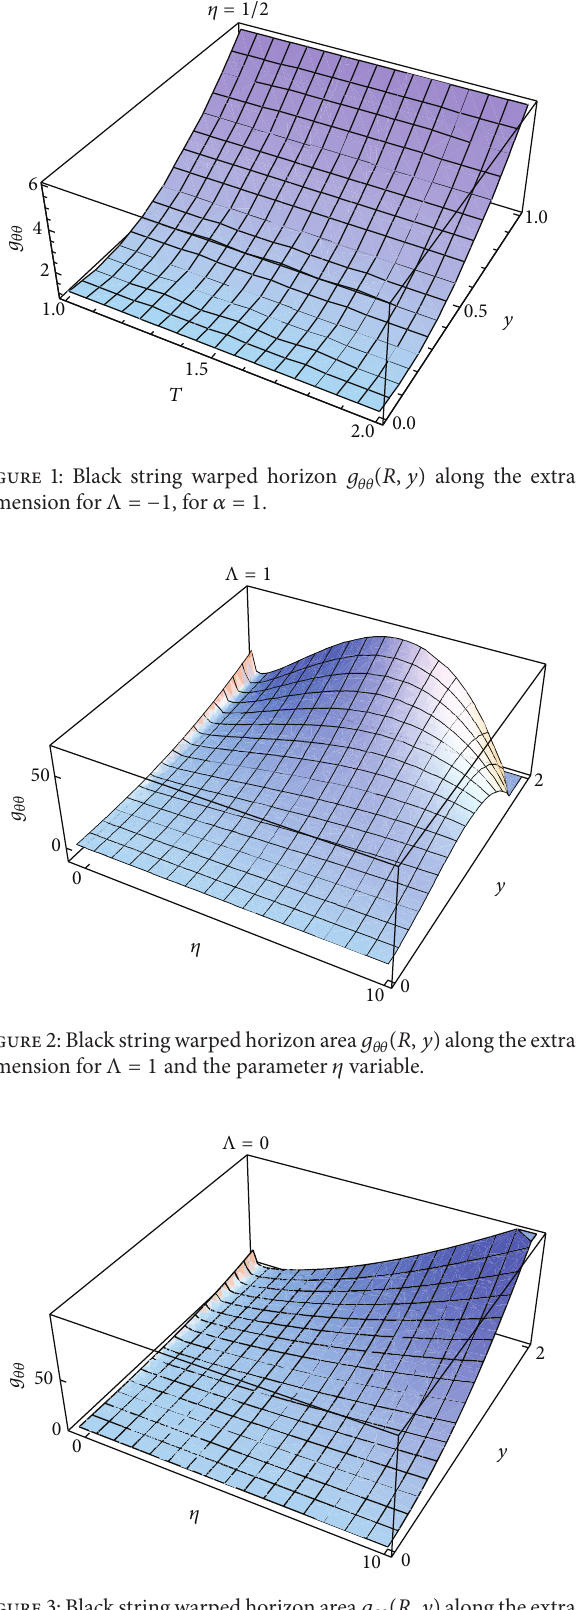
Figure 3: Black string warped horizon area 𝑔 𝜃𝜃 (𝑅,𝑦) along the extra dimension for Λ = 0 and the parameter 𝜂 variable.